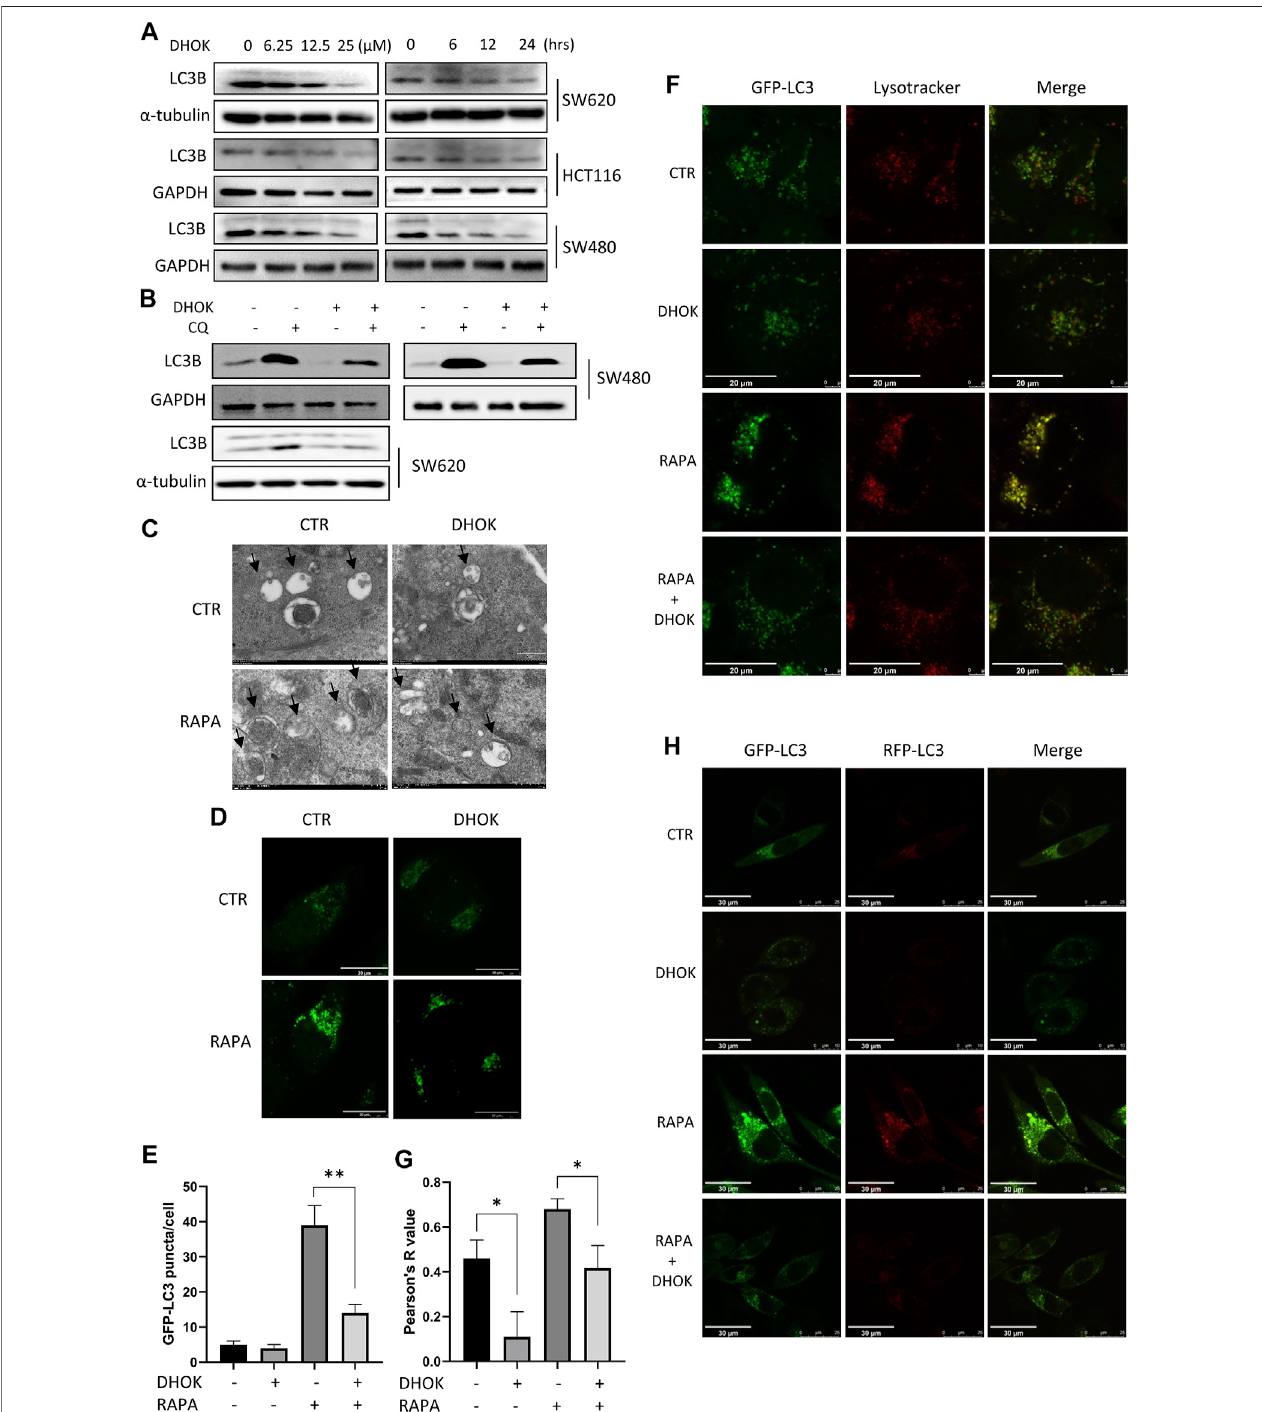
FIGURE 3 | DHOK reduced autophagy level and inhibited the fusion of autophagosomes with lysosomes. (A) Expression of the LC3 protein in SW620, HCT116, and SW480 cells under different dosage of DHOK treatment (6.25, 12.5, 25 μ M) for different time (6, 12, 24 h) was determined. (B) Expression of the LC3 protein in HCT116, SW480 and SW620 cells under DHOK treatment (12.5 μ M, 24 h) with or without CQ (10 μ M) was determined. (C) TEM images showed the ultrastructure of SW620 cells under DHOK treatment (12.5 μ M, 24 h) in the presence or absence of rapamycin (100 nM). Scale bar 0.2 μ m. (D,E) GFP-LC3 stably expressing cells were treated with DHOK (12.5 μ M, 24 h) in the presence of rapamycin (100 nM) for 24 h. Confocal images of GFP-LC3 puncta were photographed. Scale bar 20 µm. The number of GFP-LC3 puncta were quanti fi ed by ImageJ. ** p < 0.01 (F,G) HeLa cells stably expressing GFP-LC3 were stained with LysoTracker Red under DHOK treatment (12.5 μ M, 24 h) in the presence of rapamycin (100 nM) for 24 h. Confocal images of GFP-LC3 puncta and lysosomes were photographed. Scale bar 20 µm. ColocalizationindexwascalculatedbyImageJsoftware. (H) L929cellsstablyexpressingtfLC3BweretreatedwithDHOK(12.5 μ M,24 h)inthepresenceorabsenceof rapamycin (100 nM). Confocal images of GFP-LC3 and RFP-LC3 puncta were photographed (scale bar: 30 µm).